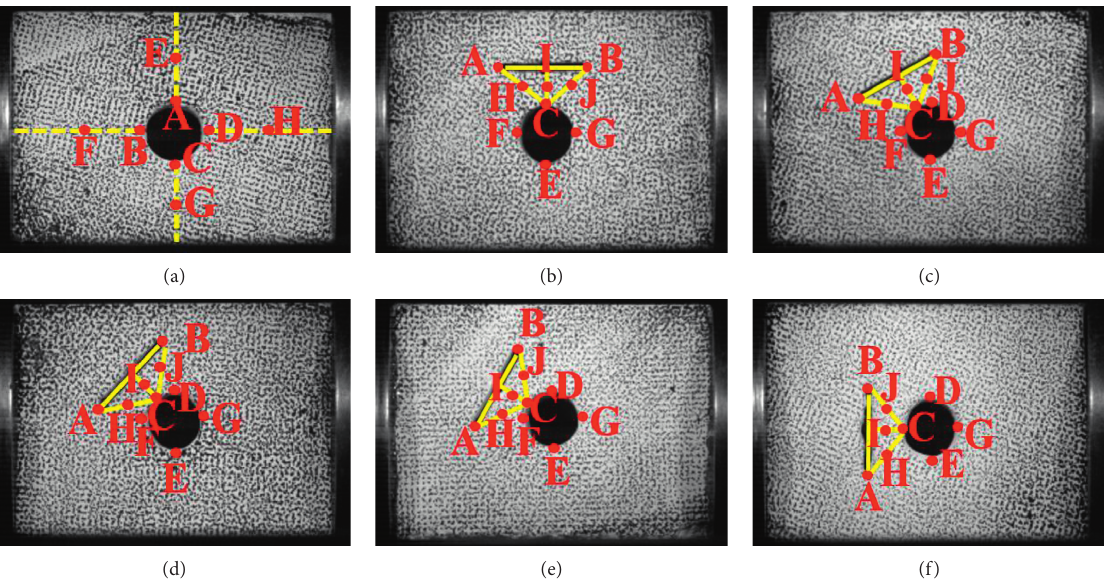
Figure 7: The measurement points of specimens: (a) with no artificial crack and (b)–(f) with artificial crack of angles 0 ° , 30 ° , 45 ° , 60 ° , and 90 ° ,